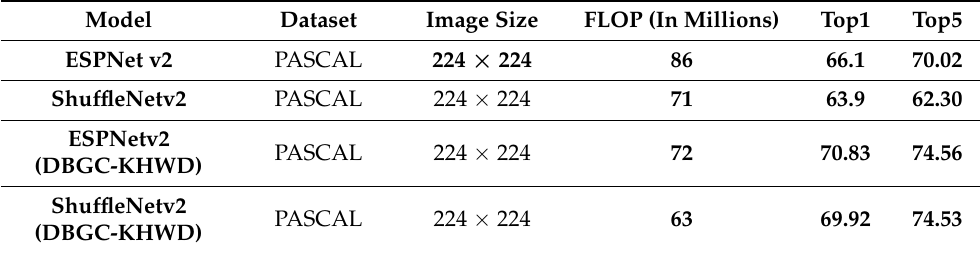
Table 9. Height + width + depth-based